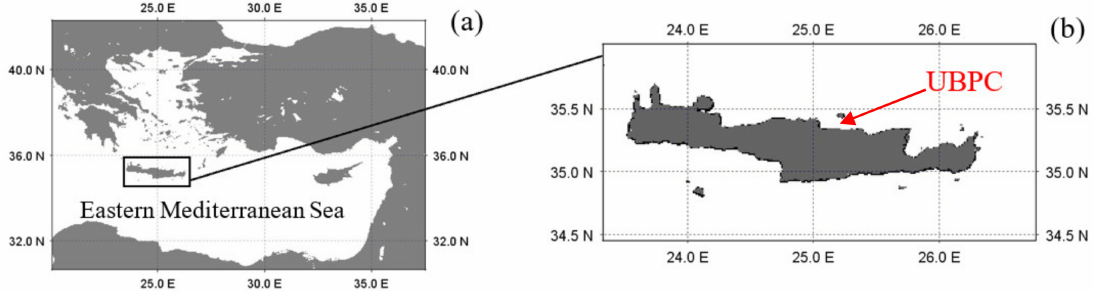
Figure 1. ( a ) Map of the Eastern Mediterranean Sea. ( b ) Location of the underwater biotechnological park of Crete (UBPC) (red arrow), almost 2 km o ff shore the northern coast of Crete island in